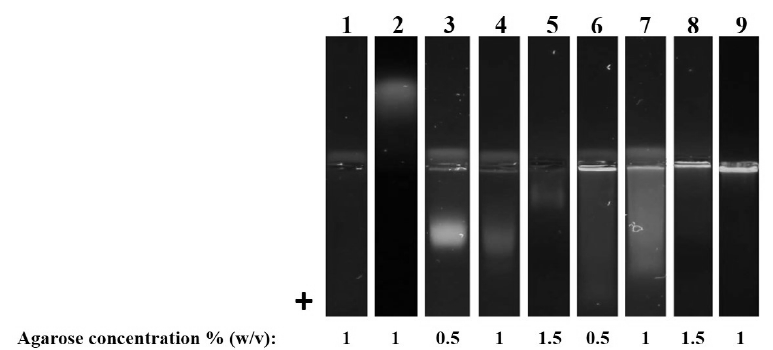
Figure 3. Agarose gel electrophoresis of EVs: ( 1 ) DiOC 6 working concentration ( 2 ) DiOC 6 10 × working concentration ( 3 – 5 ) exosome standard ( 6 – 8 ) 50,000 × g pellet V. album ( 9 ) 50,000 × g pellet V. minor